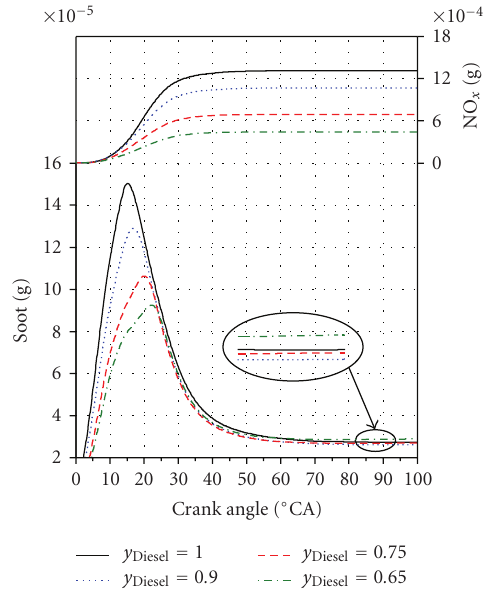
Figure 19: Soot and NO x history for di ff erent